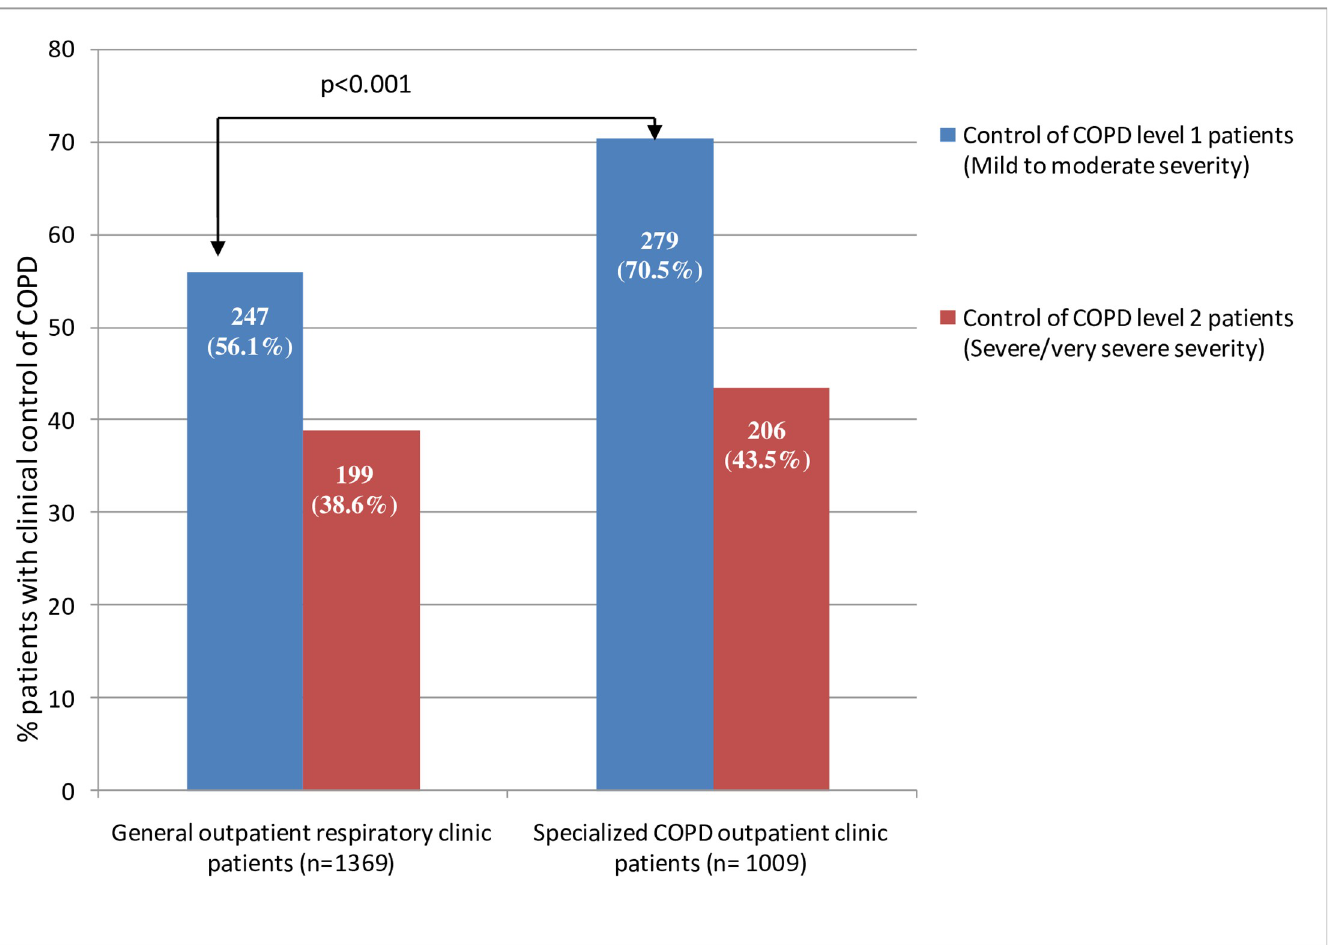
Fig 2. Control of COPD adjusted for severity in both outpatient clinic models. In patients with mild to moderate severity (BODEx � 2 points or FEV1 � 50%), to establish a situation of optimal control of COPD, the following criteria must be met: low impact [dyspnea (mMRC) 0–1 and/or CAT � 10 points] and stability defined as the absence of exacerbations in the last 6 months. In severe/very severe patients (BODEx > 2 points or FEV1 < 50%), to establish a situation of optimal control of COPD, the following criteria must be met: low impact [dyspnea (mMRC) 0–2 and/or CAT � 16 points] and stability defined as the absence of exacerbations in the last 6 months.